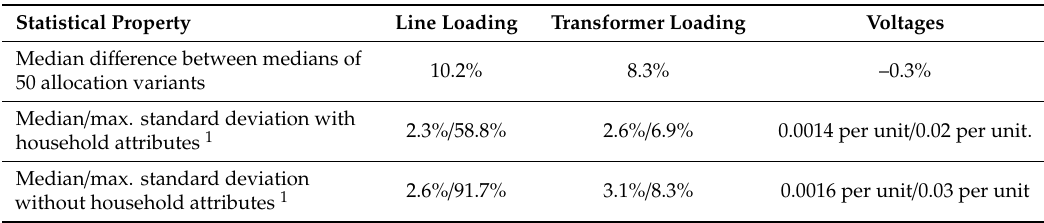
Table 4. Statistical comparison of grid calculation results based on charging point allocations with and without household